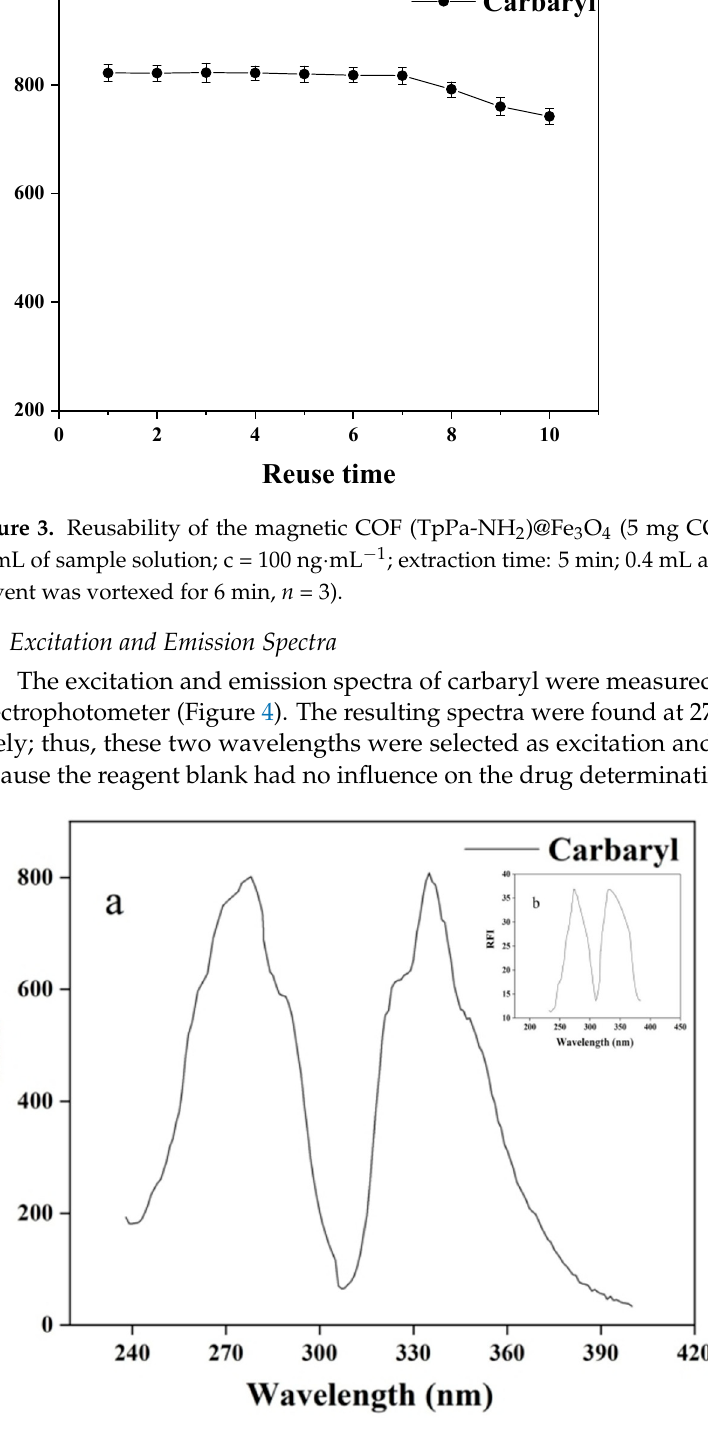
Figure 4. Excitation and emission spectra: ( a ) excitation and emission spectra of carbaryl desorbed; ( b ) excitation and emission spectra of carbaryl before extraction.